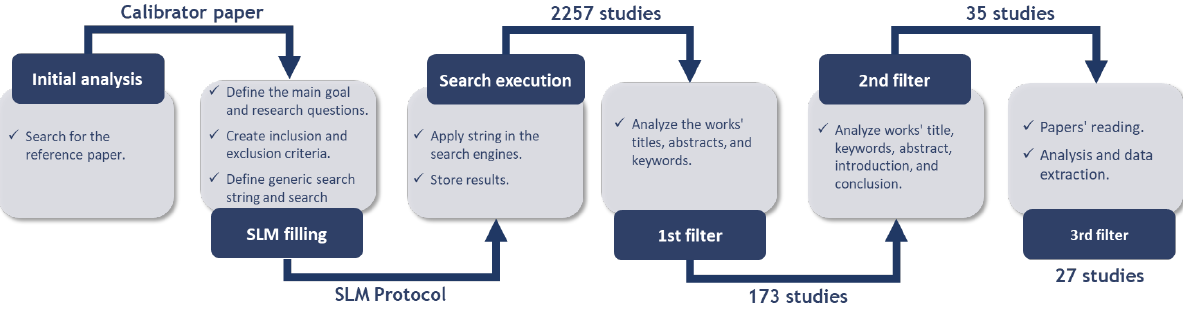
Figura 2. Systematic Literature Mapping’s